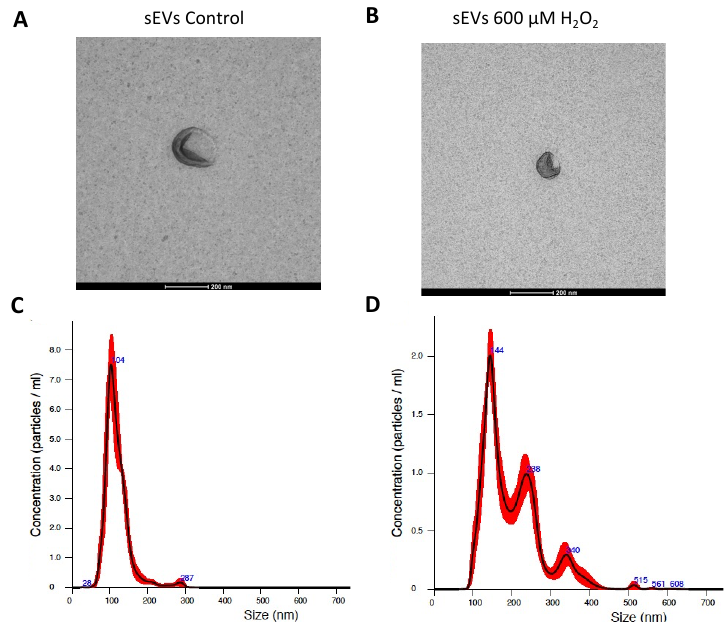
Figure 2. sEVs released by ARPE-19 cell characterization. sEVs released by control ARPE-19 cells ( A ) and 600 µM H 2 O 2 ARPE-19 cells ( B ) were observed by electron microscopy and nanoparticle tracking analysis sEV control ( C ) and sEVs H 2 O 2 600 µM ( D ) Scale bar: 200 nm.